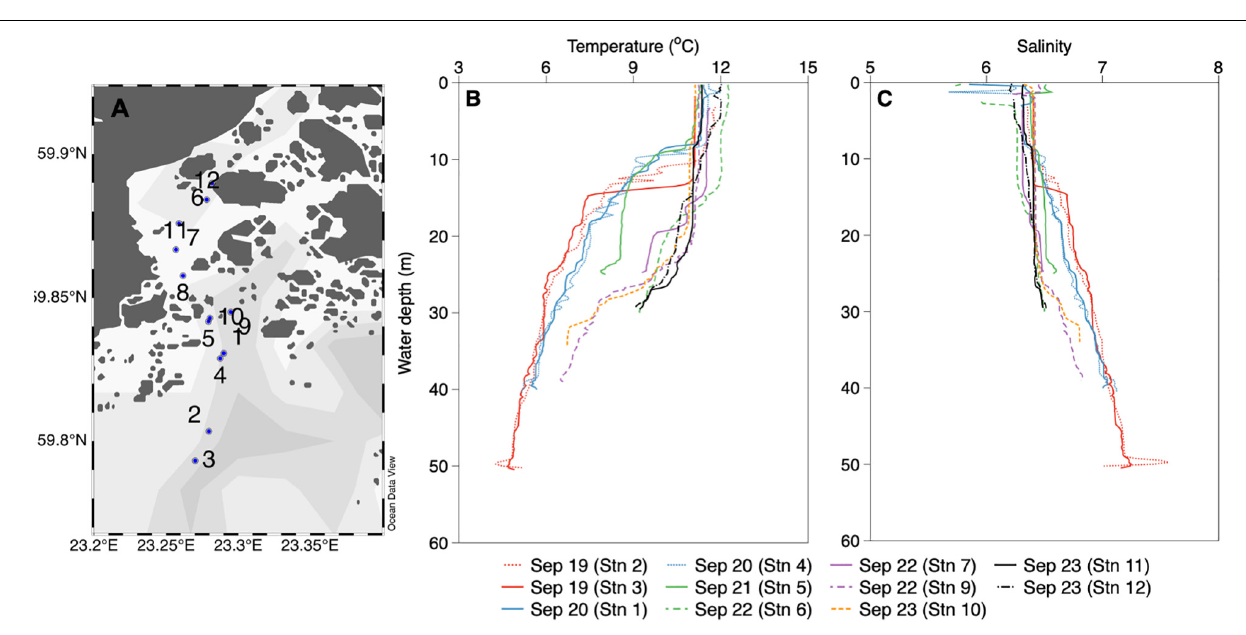
shallow coastal areas the role of such pelagic sources may presumably be less important, because the zooplankton biomass is simply limited by the lower volume of water, but this cannot be ruled